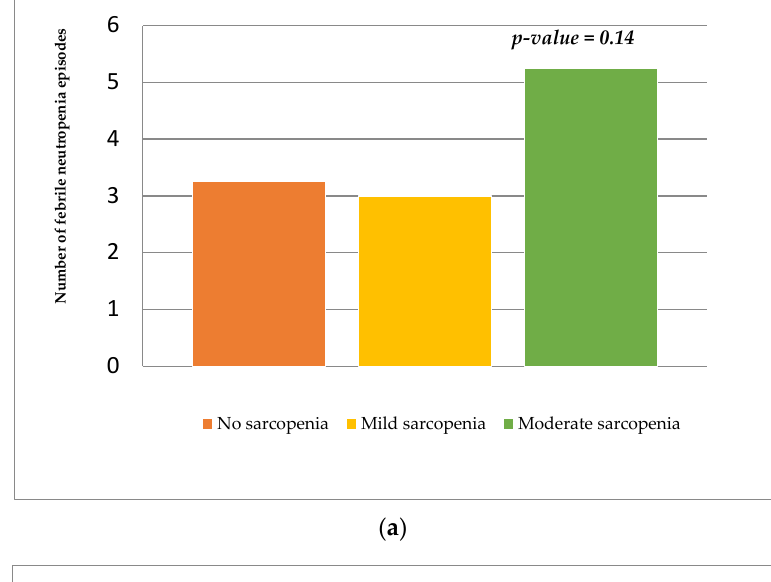
8 of 13 Abbreviations: tPMA: total area of the psoas muscle; BMI: body mass index; PNI prognostic nutritional index; Δ BMI (the change of BMI over the 12 months of treatment); Δ PNI (the change of PNI over the 12 months of treatment); Δ tPMA (the change of PMA over the 12 months); Δ tPMA L4– L5 > − 25% (reduction of PMA greater than 25% over 12 months). 3.3. Association between Sarcopenia and Infectious Complications The median number of febrile neutropenic episodes that require hospitalization and intravenous antibiotic therapy was 3 (IQR = 3–7) in nonsarcopenic patients, 2.5 (IQR = 0.5– 4.5) in mild sarcopenic patients, and 5 (IRQ 1–5.5) in moderate sarcopenic patients. The comparison between the median number of febrile neutropenic episodes that require hospitalization and intravenous antibiotic therapy was not statistically different among the nonsarcopenic, mild sarcopenic, and moderate sarcopenic groups at diagnosis, as shown in Figure 2a. Additionally, the median number of febrile neutropenic episodes that require hospitalization and intravenous antibiotic therapy was 2 (IQR = 2–5.75) in patients with Δ tPMA L4–L5 < − 25% and 2 (IQR = 3.5–5) in patients with Δ tPMA L4–L5 > − 25%. The comparison between the median number of febrile neutropenic episodes that require hospitalization and intravenous antibiotic therapy was not statistically different among